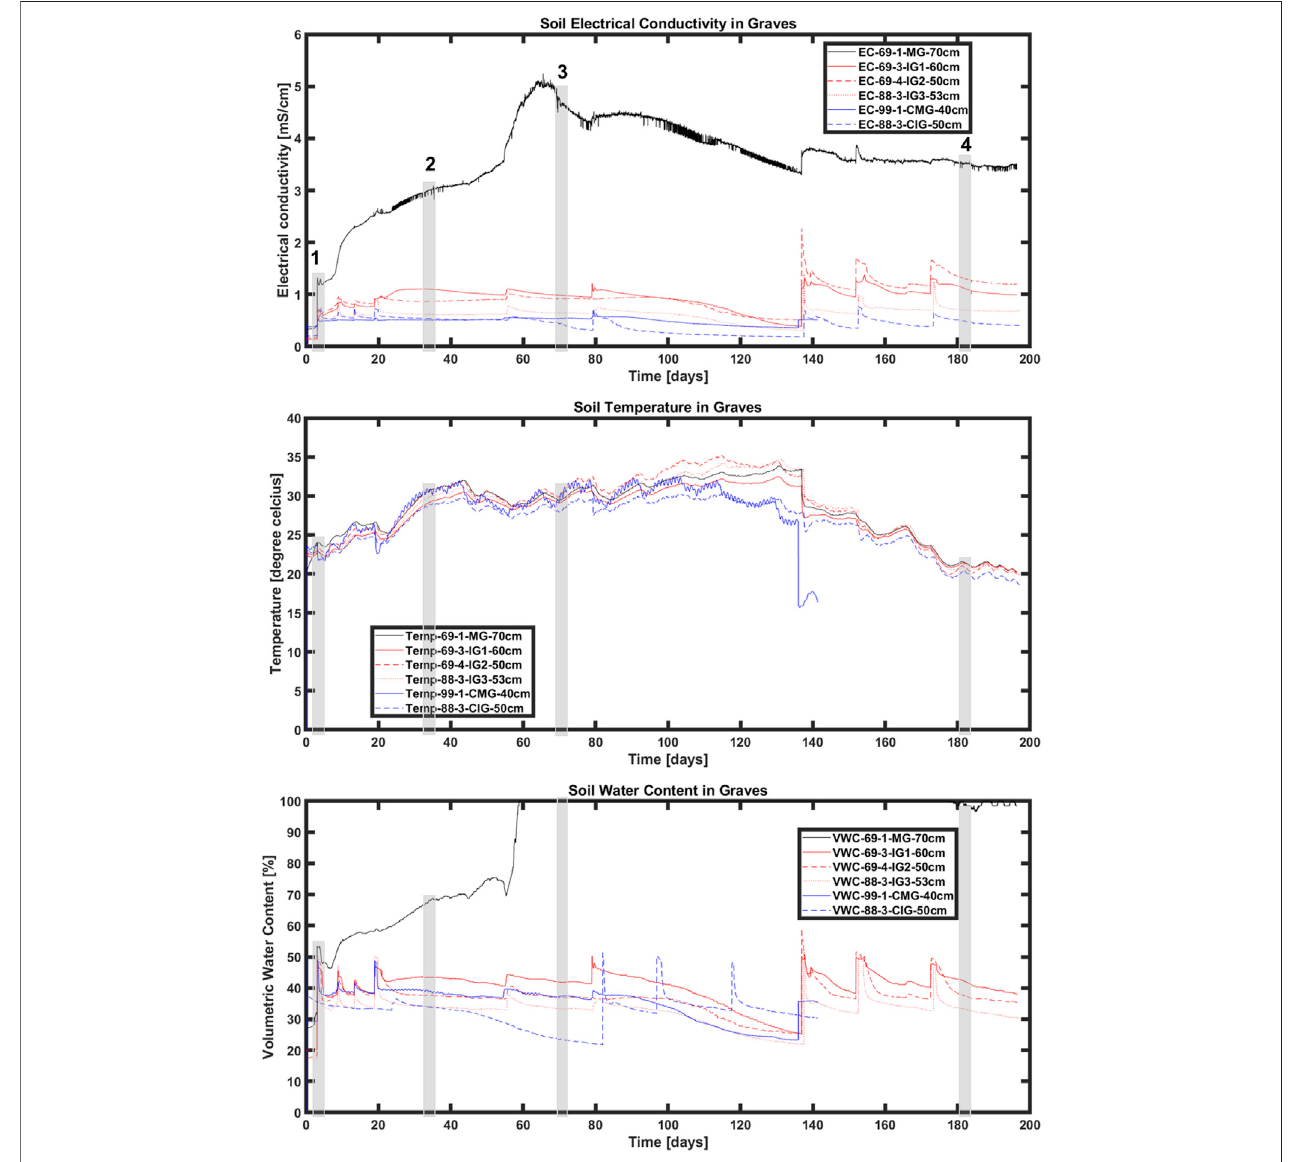
FIGURE 10 | Soil electrical conductivity (top row), temperature (middle row), and volumetric moisture content (bottom row) measured in the mass grave. Highlighted locations 1 to 4 are dates when post-burial geophysical measurements were conducted.